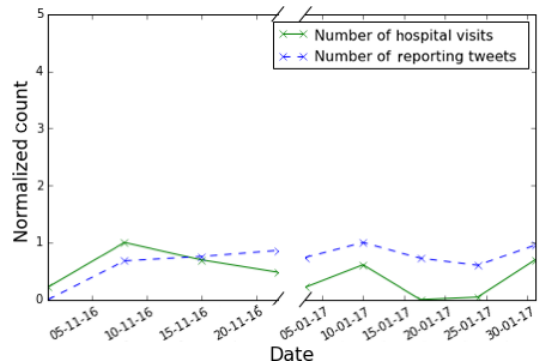
Fig. 11 Count of combined English and Arabic tweets (classified as self and nonself) versus count of actual hospital